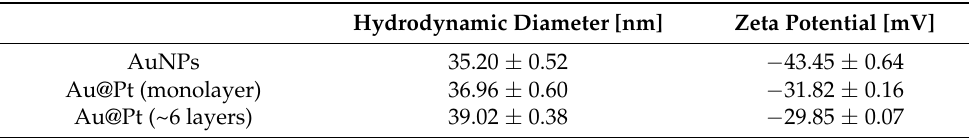
Figure 1. HR-TEM images for AuNP ( A , B ) and Au@PtNP ( C , D ).